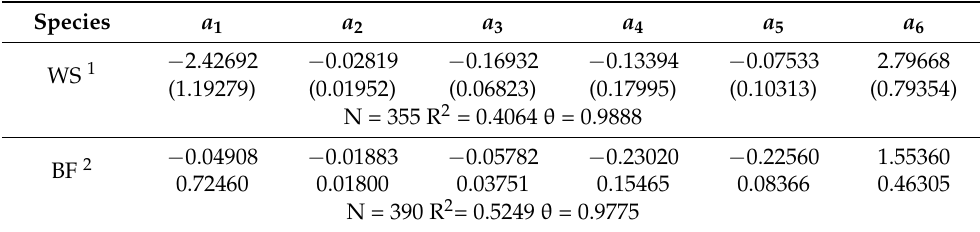
Table 4. Parameter estimates, along with their standard errors in brackets and Snowdon’s